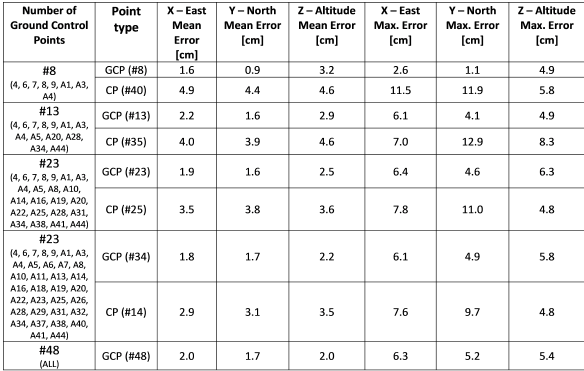
Figure 11: Orientation statistics with different GCPs configura- tions.